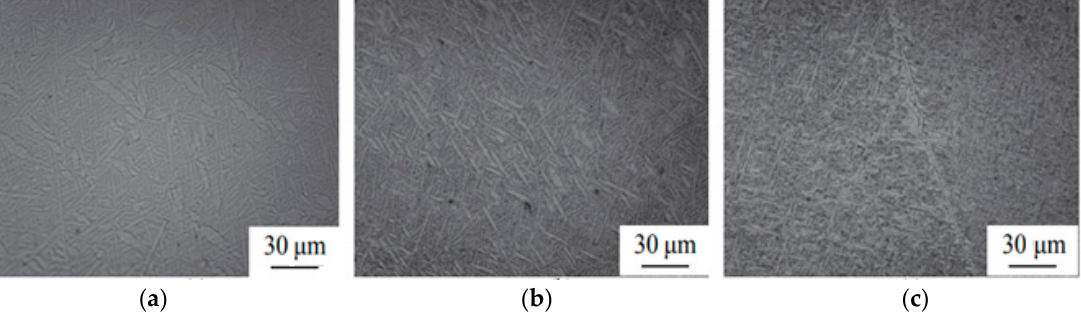
Figure 3. Optical microscopy in top region ( a ) Sample-2, ( b ) Sample-3 and ( c ) Sample-4 (Reused by permission form [89], License number 5462390275210).